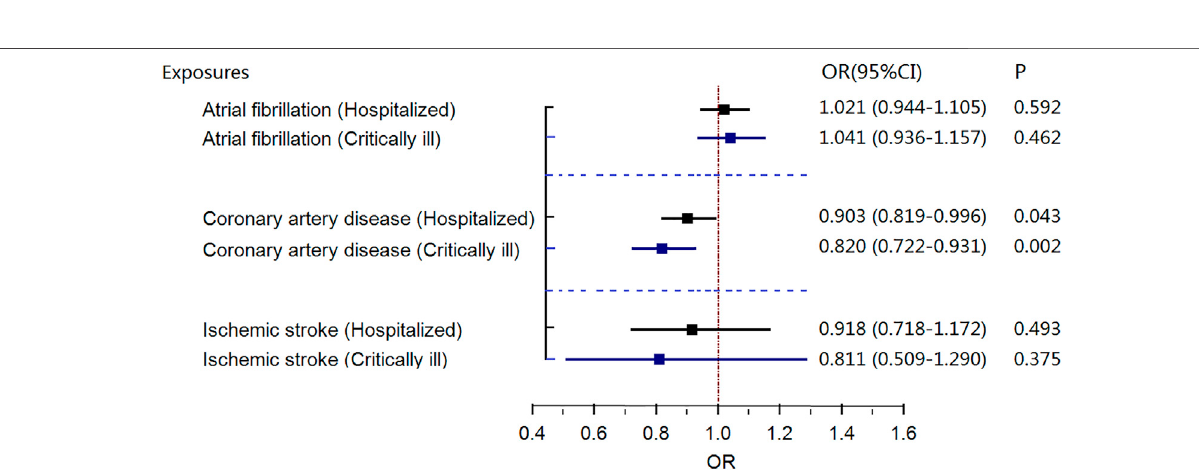
FIGURE 3 | Results of the random-effects MR IVW model investigating the causal association between gene-predicted three cardiovascular diseases and risk of severe coronavirus disease 2019 (COVID-19) in COVID-19 GWAS data. CI, con fi dence interval; OR, odds ratio; MR, Mendelian randomization; COVID-19, severe coronavirus disease 2019.